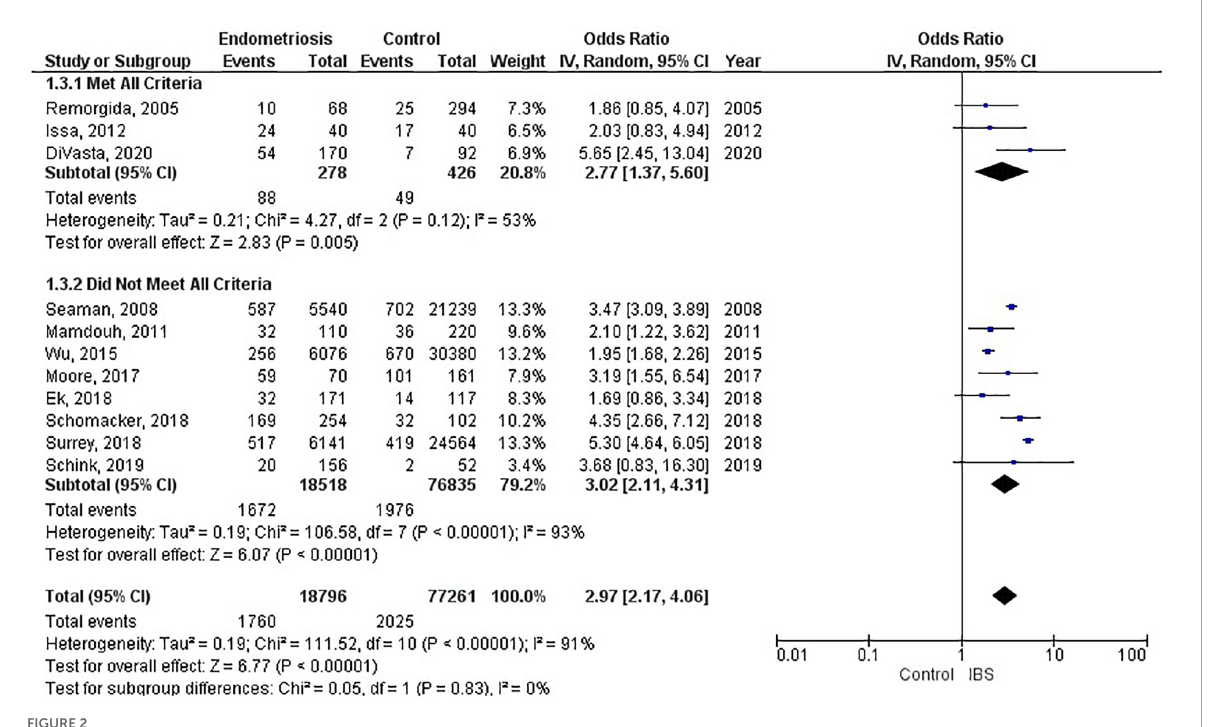
FIGURE2 Forest plot by all